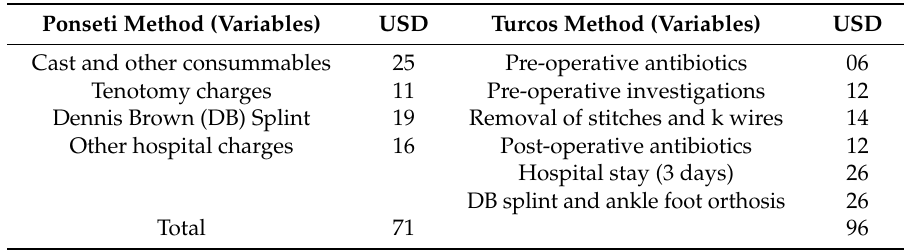
Table 5. Distribution of